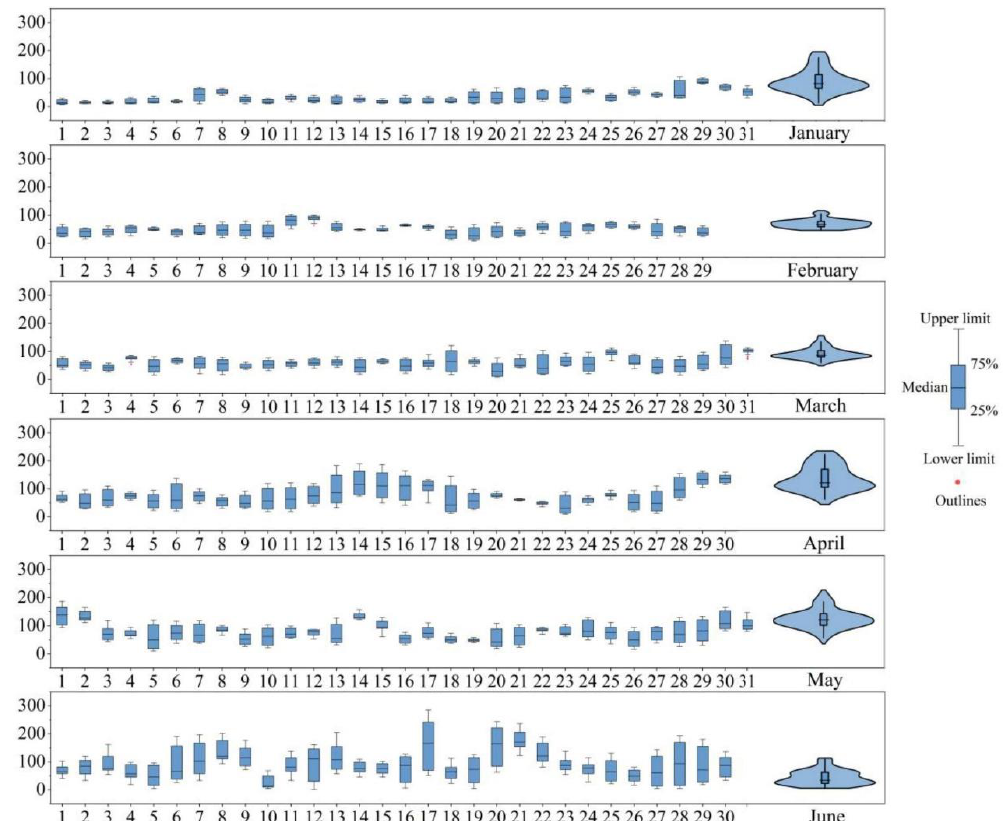
Figure 3. Daily series box plot and monthly average violin plot of ozone concentration from January to